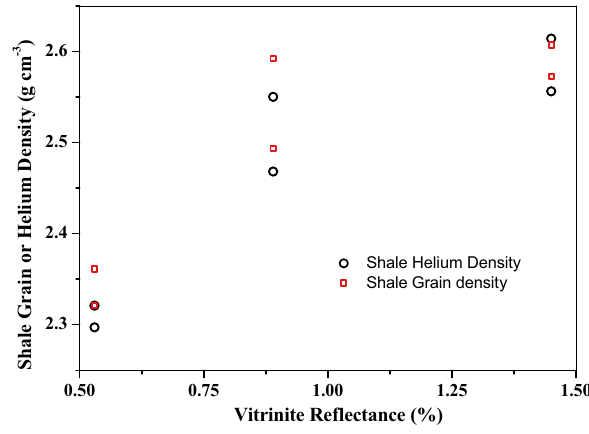
Fig. 16 The variation of helium and grain densities for shales for Posidonia shales with vitrinite reflectance (data from Ref.